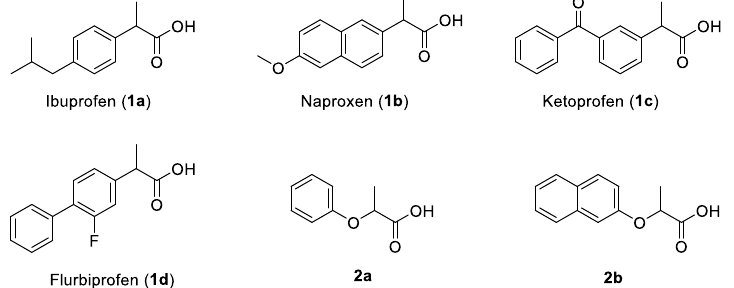
Figure 1. 2-Arylpropionic acids NSAIDs ( 1a – d ) and 2-aryloxypropionic acids ( 2a,b